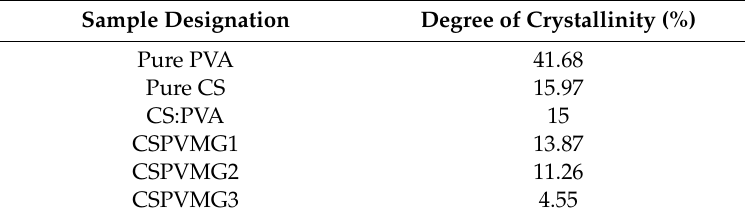
Table 2. The degree of crystallinity using XRD spectra